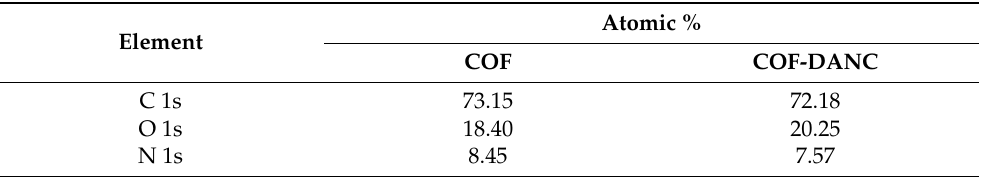
Table 1. Summary of XPS atomic mass ratio of different